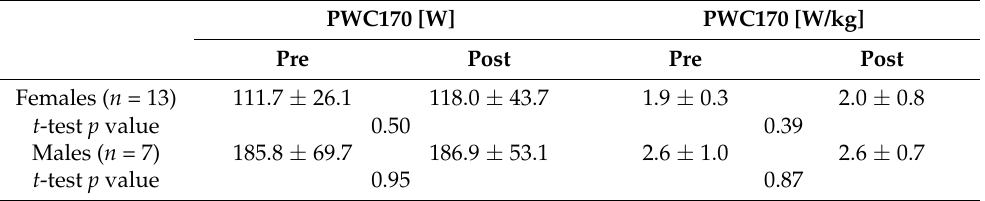
Table 2. Physical Work Capacity 170 test with Tourism and Recreation students during a 14-week period of the COVID-19 pandemic. Data are presented as mean value ± standard